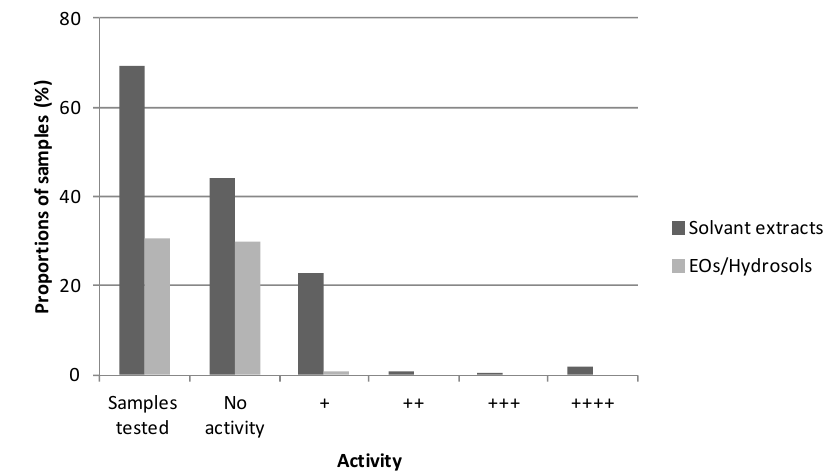
Figure 3. Proportions of samples (%) tested in triplicate and presenting whitening activity (++++: 80% ≤ tyrosinase inhibition ≤ 100%; +++: 60% ≤ inhibition ≤ 80%; ++: 40% ≤ inhibition ≤ 60%; +: 20% ≤ inhibition ≤ 40%; positive control = kojic acid).